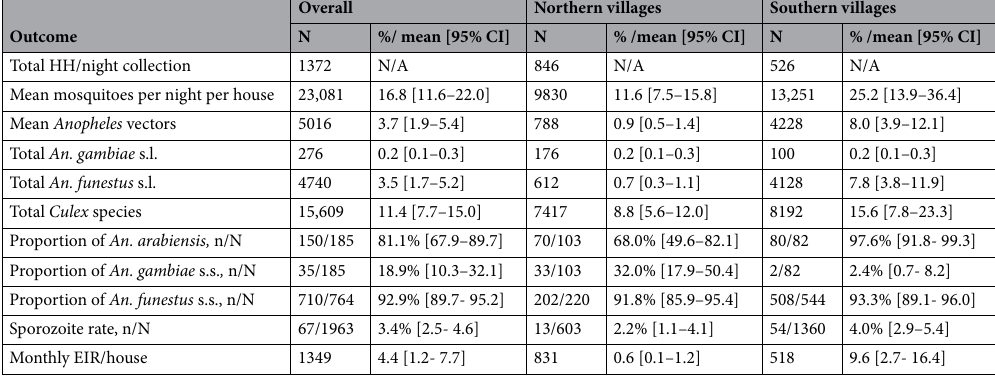
Table 2. Malaria vector species composition, sporozoite rate and entomological inoculation rate (EIR) per study zone. EIR entomological inoculation rate, HH household, N/A not